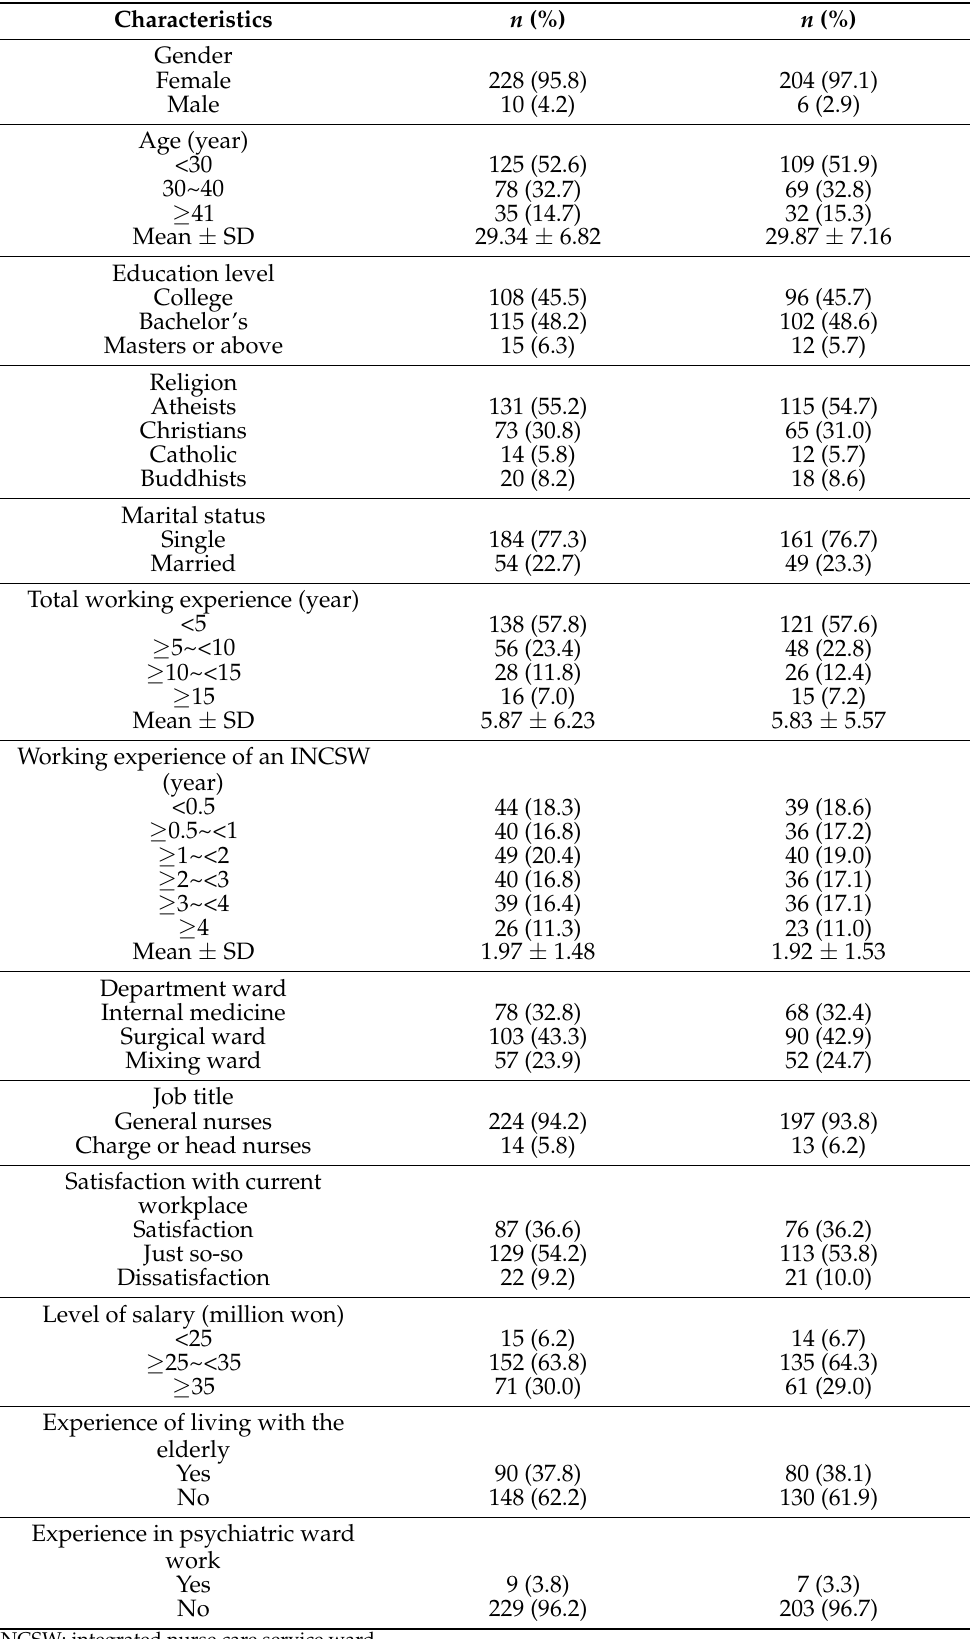
Table 1. General characteristics of study